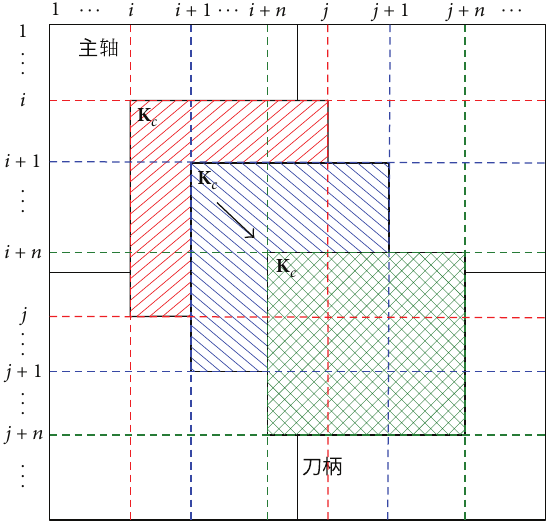
Figure 7: Schematic diagram of joint stiffness assembly.